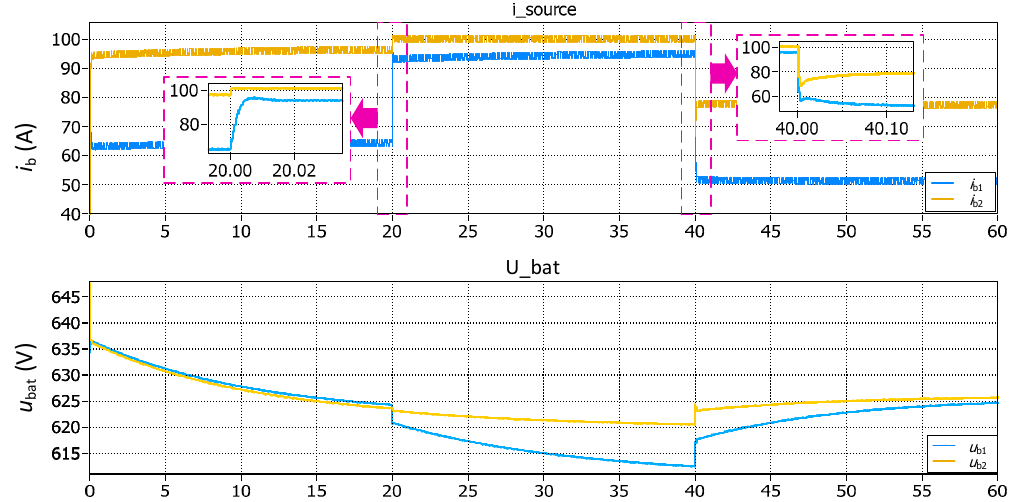
Figure 10. Battery current and voltage in all-electric mode.